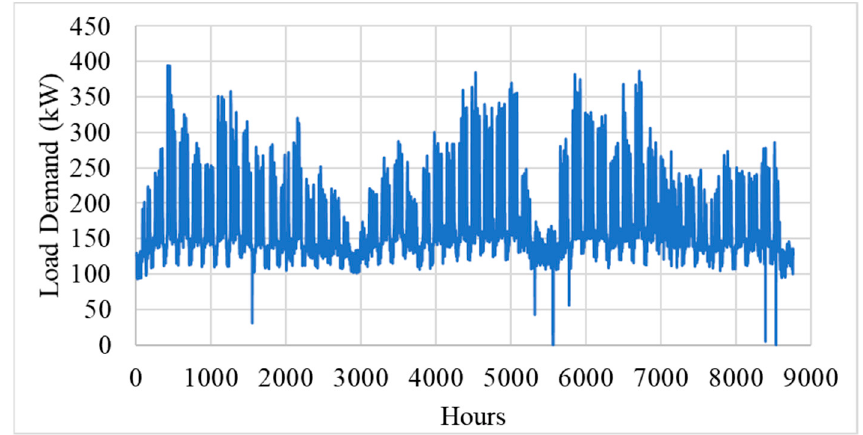
Figure 2. Hourly time series for load demand for the HMU campus.